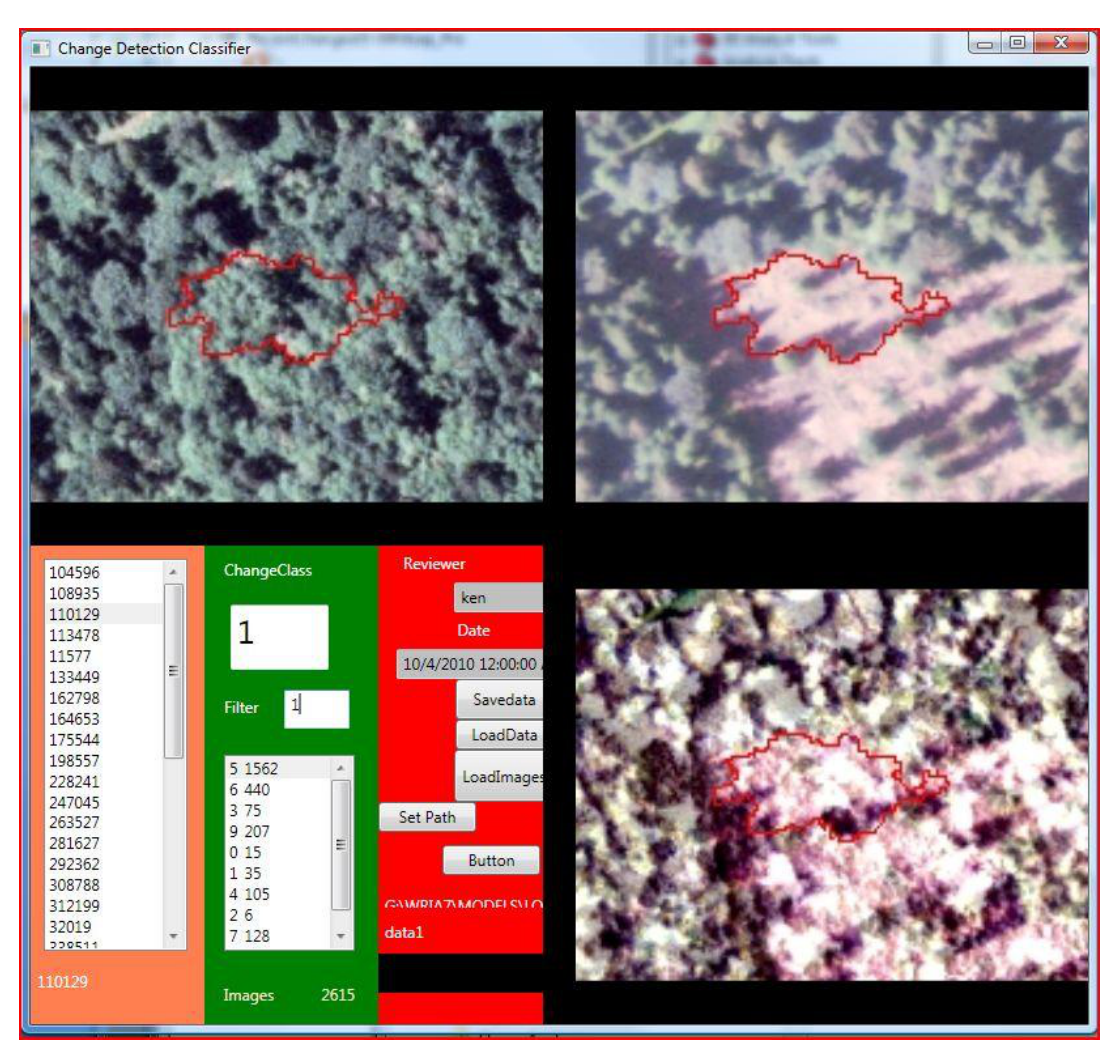
Figure 4. AAViewer. The AAViewer program displays three images and an attribution pane for rapidly classifying target polygons. In the figure, the upper left image is from 2006, the upper right image is from 2009, and the lower right image is the band-wise difference image. The ChangeClass box stays selected during review and movement between image sets is done with the “W” and “S” keys. The classification procedure requires 2 keystrokes, “S” to advance image sets and 1–9 to denote the change